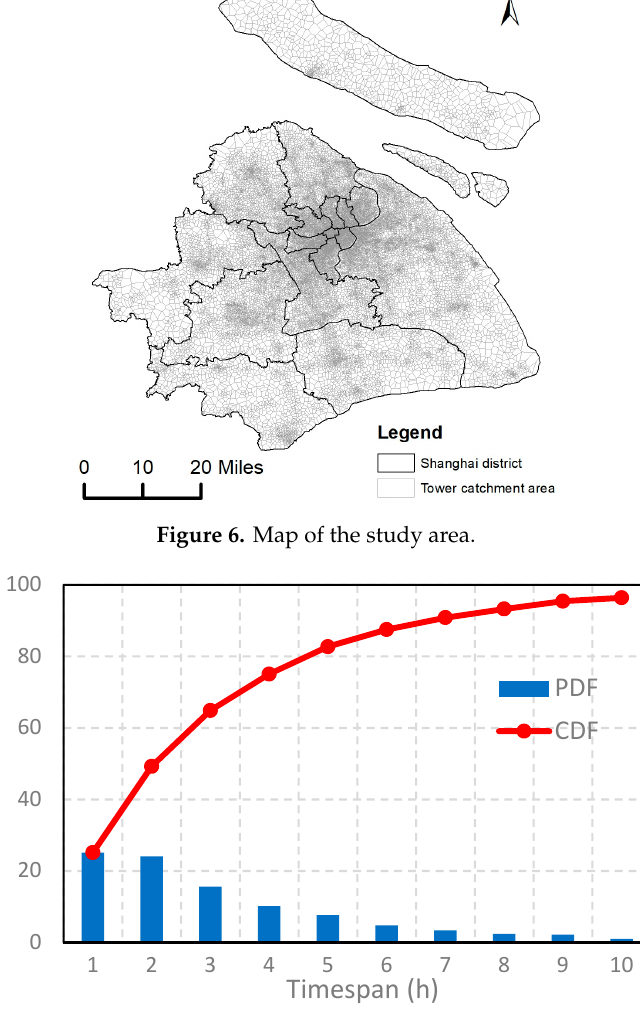
Figure 7. The distributions of the probability density function (PDF) and the cumulative distribution function (CDF) of time intervals between two adjacent call detail records in the recorded mobile phone data.